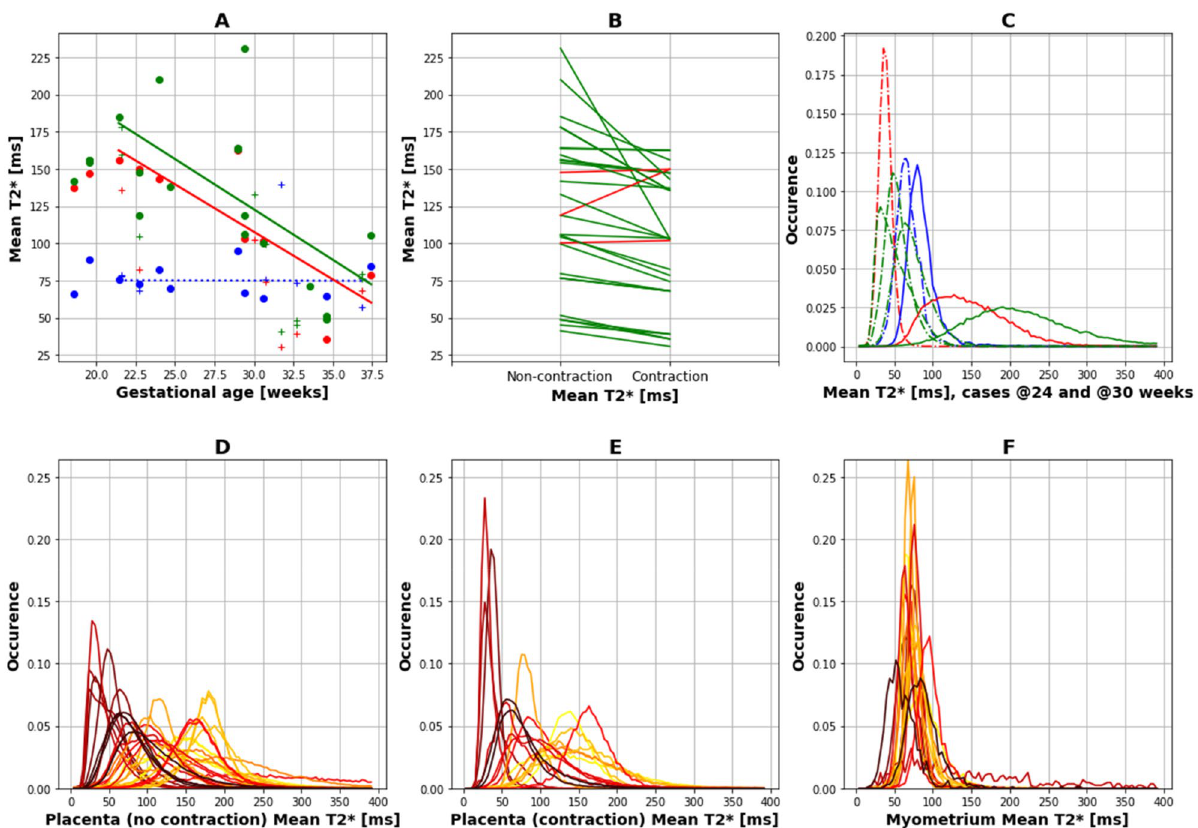
Figure 4. ( A ) Quantitative region-specific results for the detected contractions. Mean results are shown (a) for the placental ROI in a contraction-free time frame (green), in a contractile state (red) and in the underlying myometrium (blue). ( B ) Mean for non-contractile and for contractile placenta regions in green if the non- contractile mean is lower and red if the contractile mean is higher. ( C ) Histograms, depicting the fraction of voxels (occurence) for bins between 1 and 400for two exemplary cases at 24 (continuous line) and 30 weeks (dotted line) are depicted using the same colour coding. ( D – F ) Histograms for all subjects are shown for ( D ) non-contractile, ( E ) contractile placenta and ( F ) the myometrium color-coded by gestational age (bright yellow 18 weeks to dark red 37 weeks).